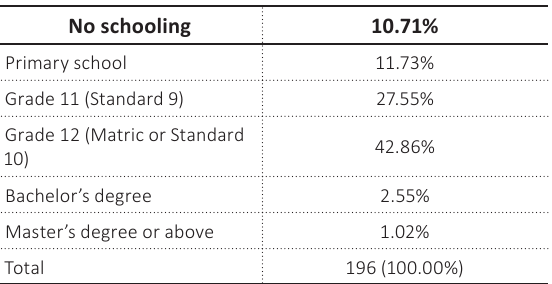
Table 2. Level of formal education ( n = 196)